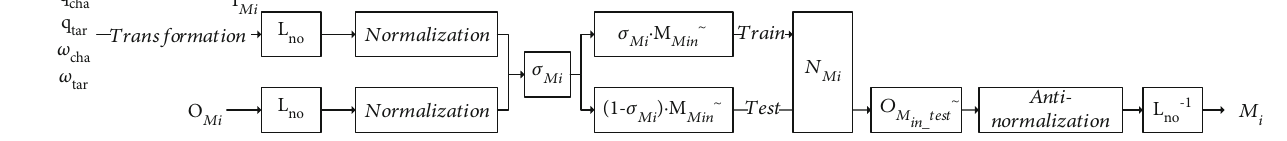
Figure 9: Training process of the attitude control network N